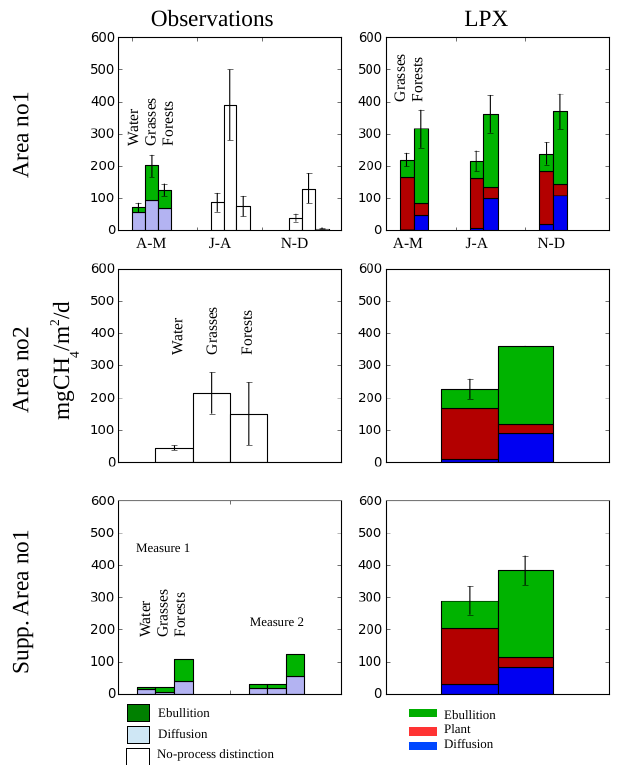
Fig. 7. Comparison between observed/simulated CH 4 flux densities over large geographical areas. The three rows of figures correspond to the different geographical areas defined in Table 6. Observations are shown in left hand panels while LPX simulations are plotted in the right column. Error-bars given for LPX corre- spond to variability between simulations described in Table 5 and ways to select the grid cells to compute the mean CH 4 flux density (i.e., ways to define a grid cell as flooded forest or flooded grass; see Appendix